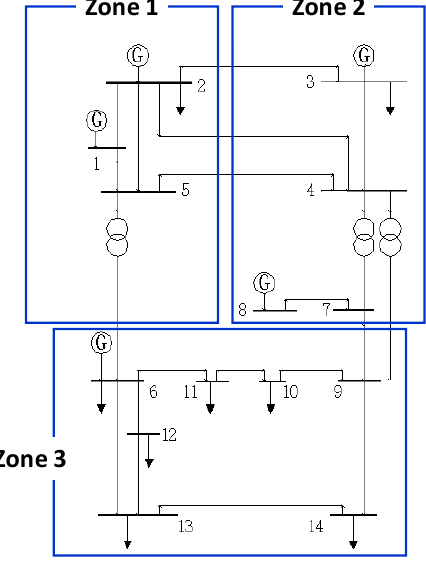
Figure 7. Zone figure of IEEE 14 system. Table 1. System Renewable Power Configuration.